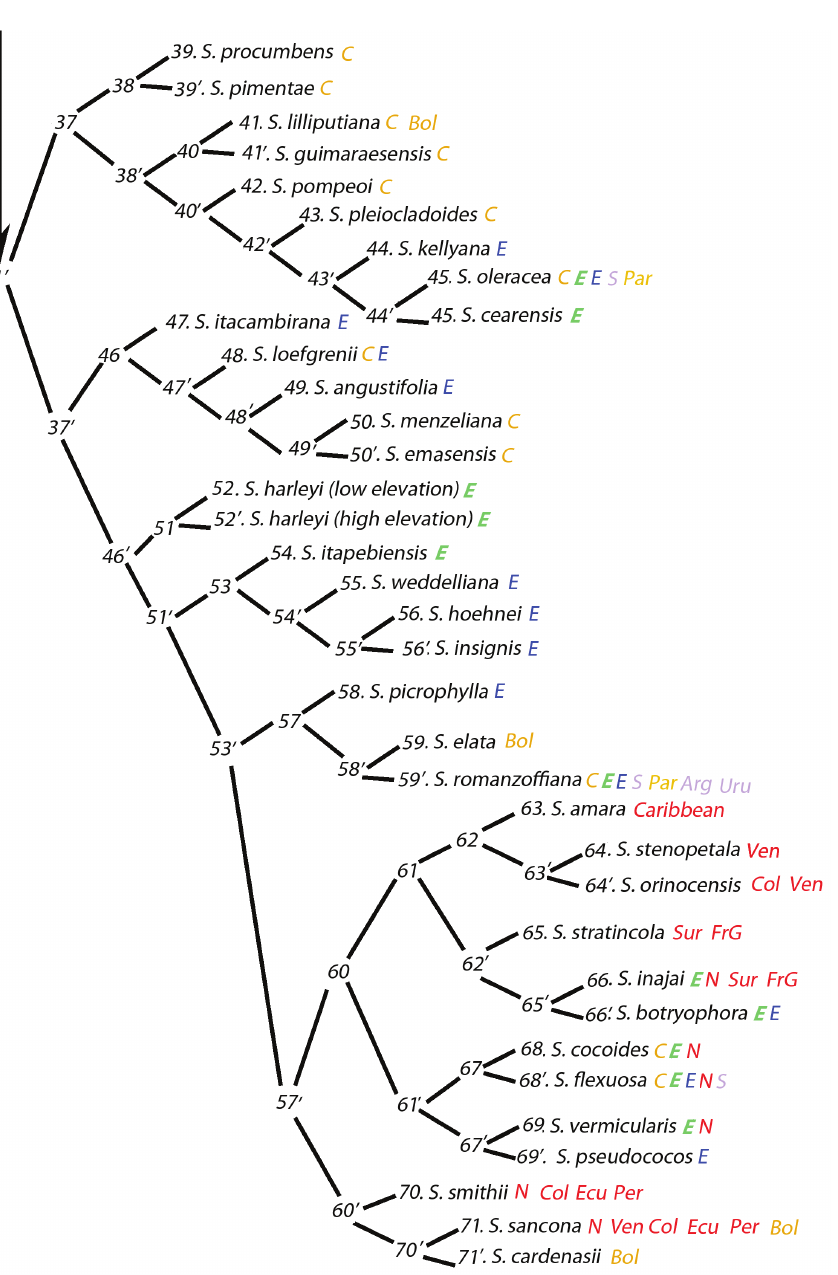
Figure 10. Continuation of the diagram of the anatomical key to Syagrus . Branch 1’. Colored letters represent regions of distribution for that species. For regions of Brazil: Orange C = Central-West Green bold italic E = Northeast Blue E = Southeast Red N = North and Violet S = South. For other countries: Arg = Argentina Bol = Bolivia Col = Colombia Ecu = Ecuador FrG = French Guyana Par = Paraguay Per = Peru Sur = Surinam Uru = Uruguay and Ven =